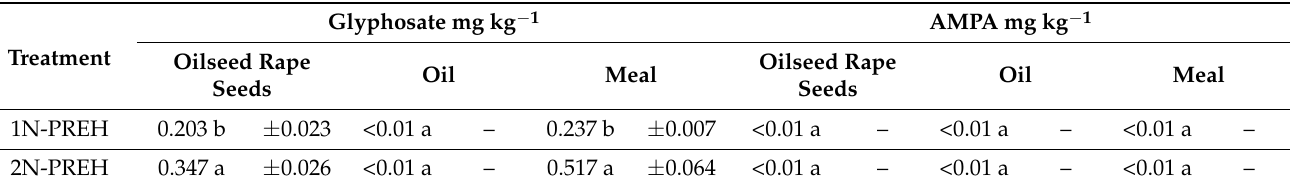
Table 4. The influence of pre-harvest (PREH) application, at maximum (1N) and double (2N) label rates, on glyphosate and AMPA residues in harvested spring oilseed rape seed, as well as in its final products,